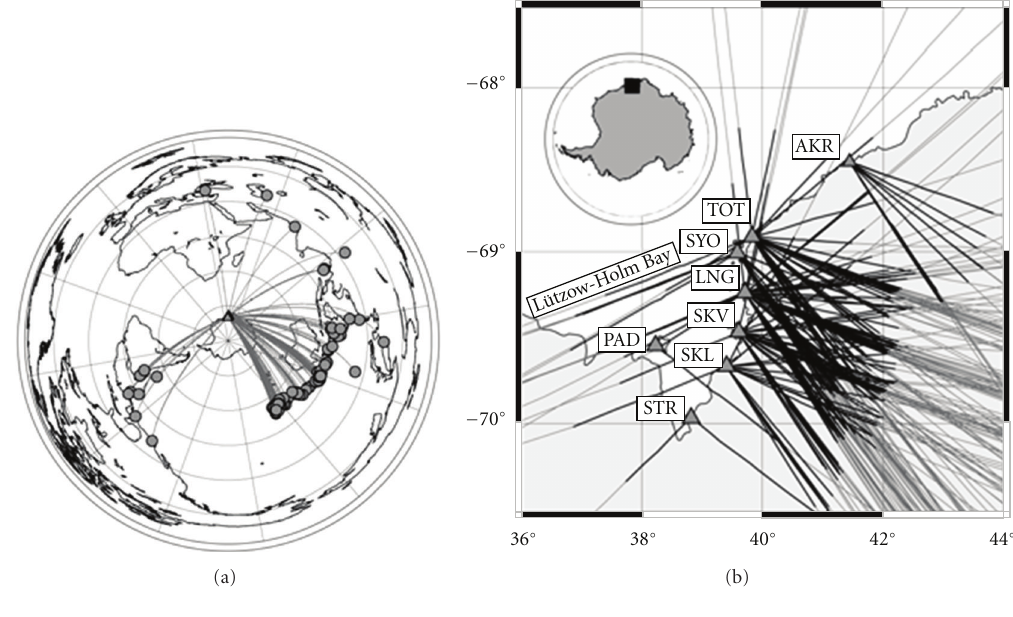
Figure 8: (upper) The global distribution of teleseismic events (solid circles) and used stations in LHB for SKS analysis (triangles). Gray lines are the ray paths from the sources. (lower) Map of the study area in LHB showing the seismic stations (triangles). Gray lines indicate SKS wave paths, and black lines indicate wave paths above 410 km depth. All the figures are after Usui et al.